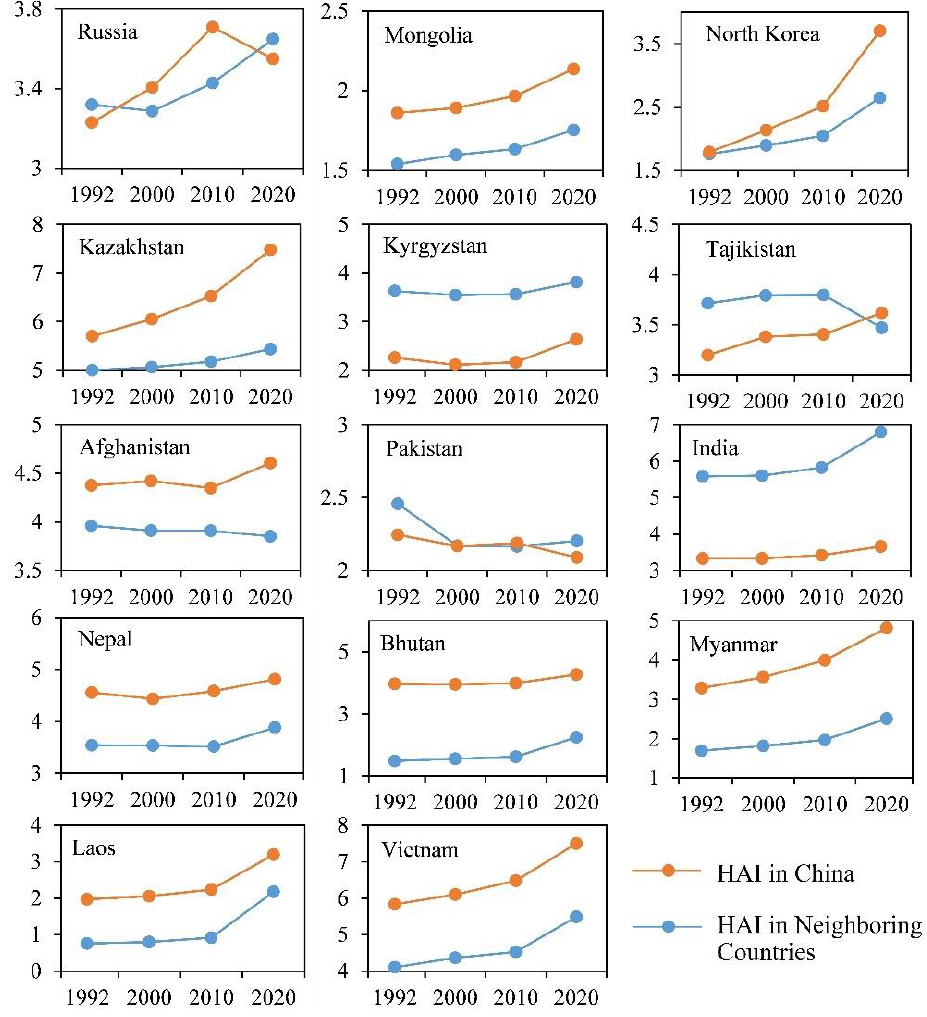
Figure 5. HAI changes between China and its neighboring countries.